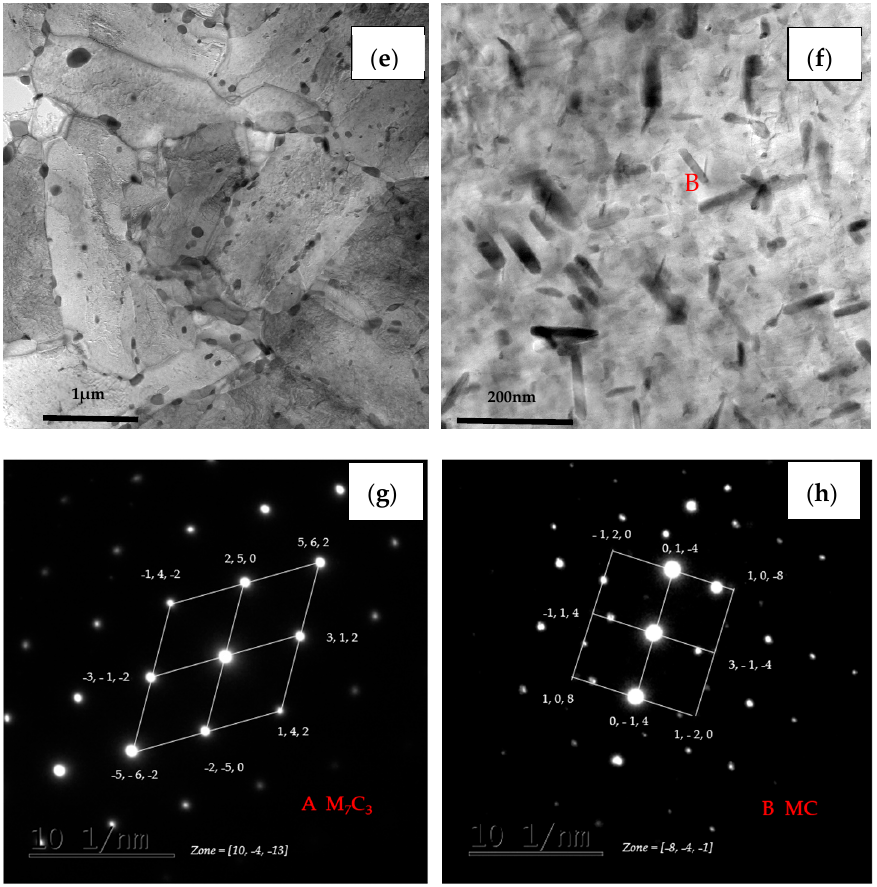
Figure 11. TEM micrographs of ( a ) steel A, ( c ) steel B and ( e ) steel C specimens; ( b , d , f ) are higher magnification images of ( a , c , e ); ( g , h ) are SAED of carbide patterns indicated with arrows in ( b ) and ( f ).